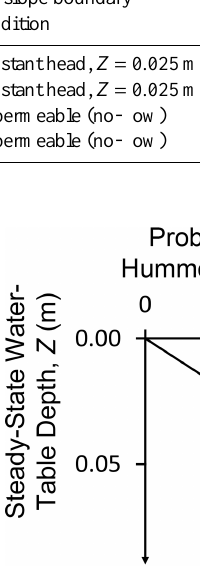
Figure 3. Graphical representation of the linear probability func- tion used by the ecological submodel to assign hummock and hol- low states to each model cell, based on water-table